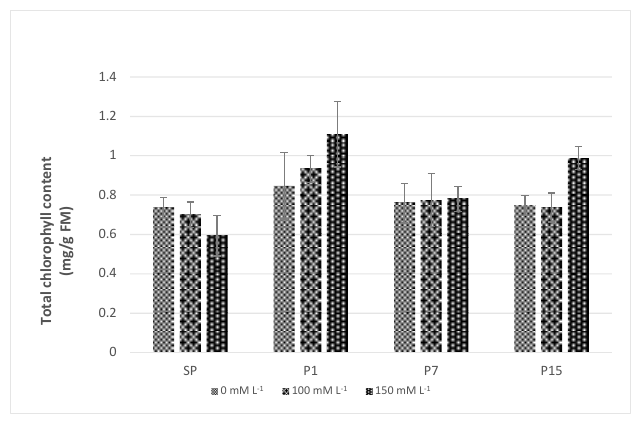
Fig. 2 The effect of salinity and bacterial inoculation with Pseudo- monas strains (P1, P7, and P15) on the total chlorophyll content of Vicia faba plants. SP is a control that was not inoculated.